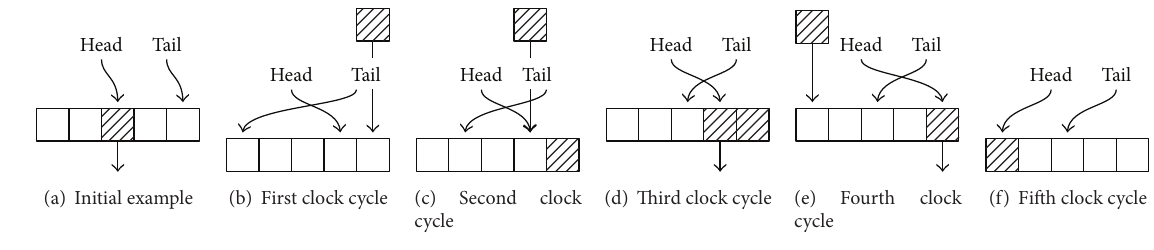
Figure 11: Reorder queue example.